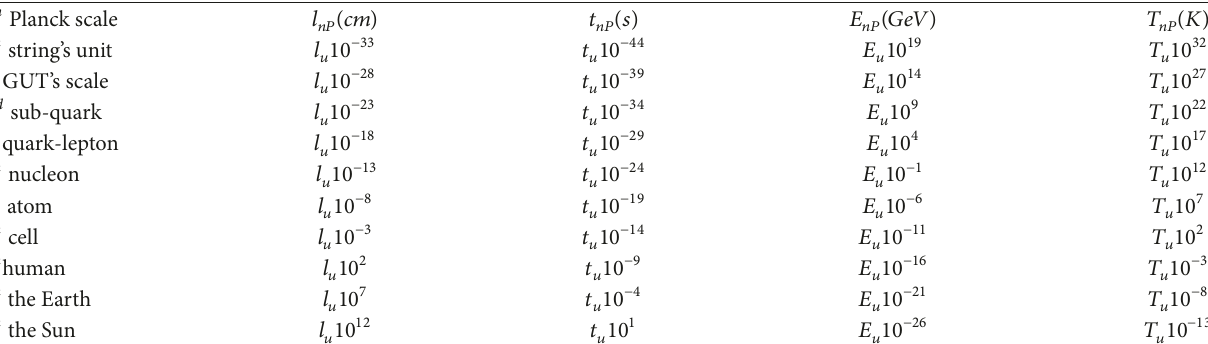
Table 1: Different characteristic times, energies, and temperatures for different matter strata from Planck scale to the star Sun-scopic scale, 𝑙 = 1.61620 , 𝑡 = 5.3910596 , 𝐸 = 1.22093 , and 𝑇 = 1.41683057 𝑢 𝑢 𝑢 𝑢